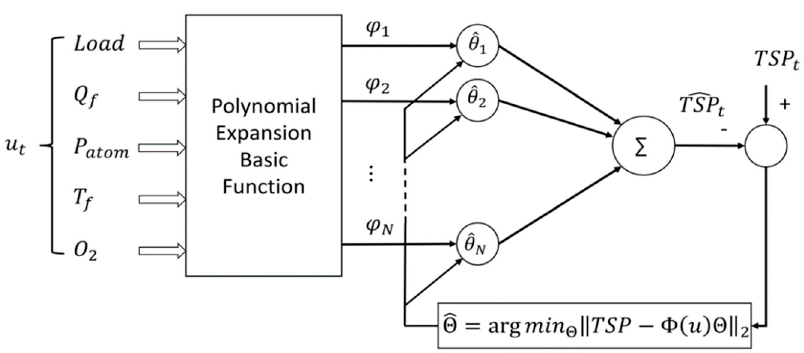
Figure 5. Polynomial basis function (PBF)–artificial neural networks (ANN) model structure for TSP modelling.